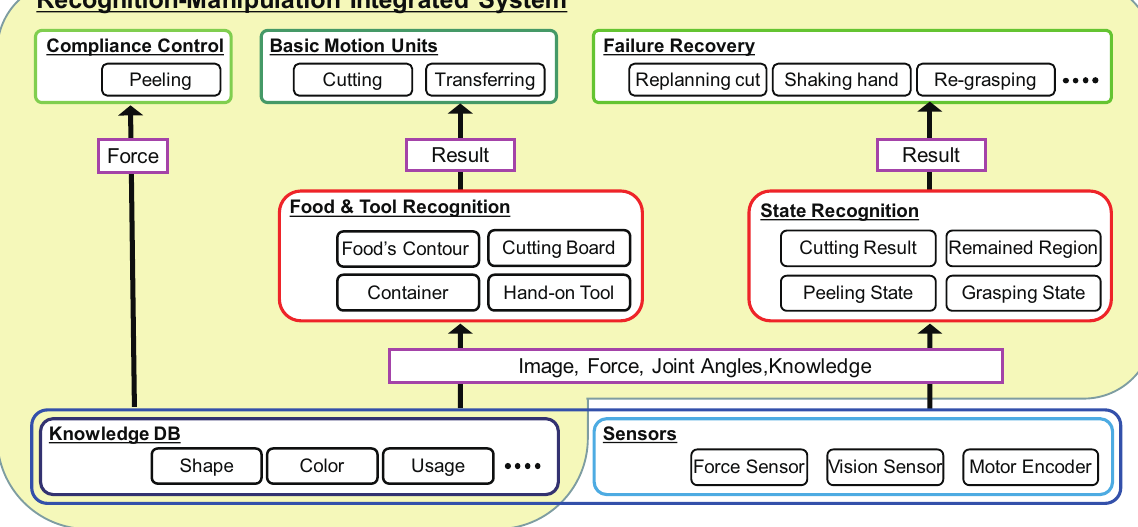
erence edge and calculate the differences of them. That is,